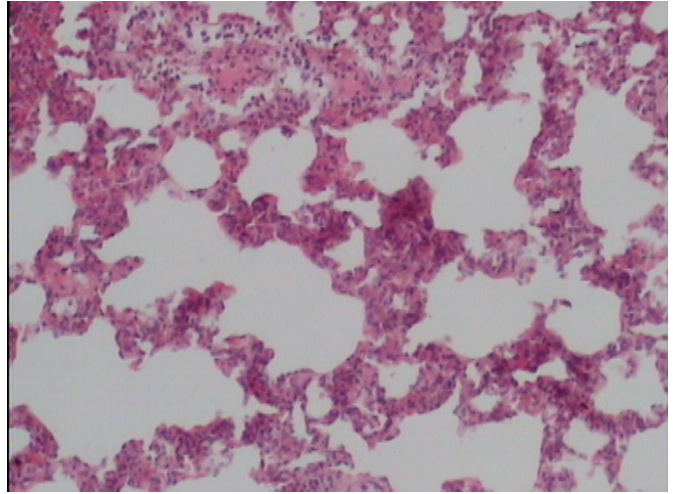
Figure 2. Synbiotic treated group.